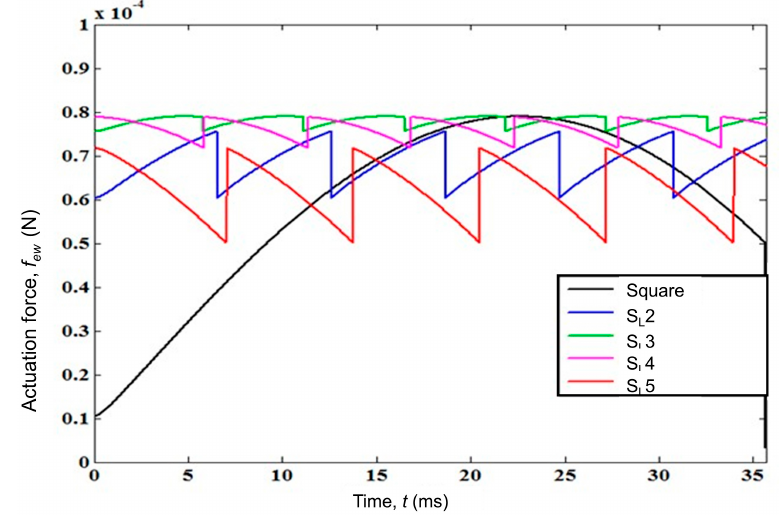
Figure A1. Actuation force ( f ew ) with time on a circular droplet for various electrode operation schemes (rigid body model).